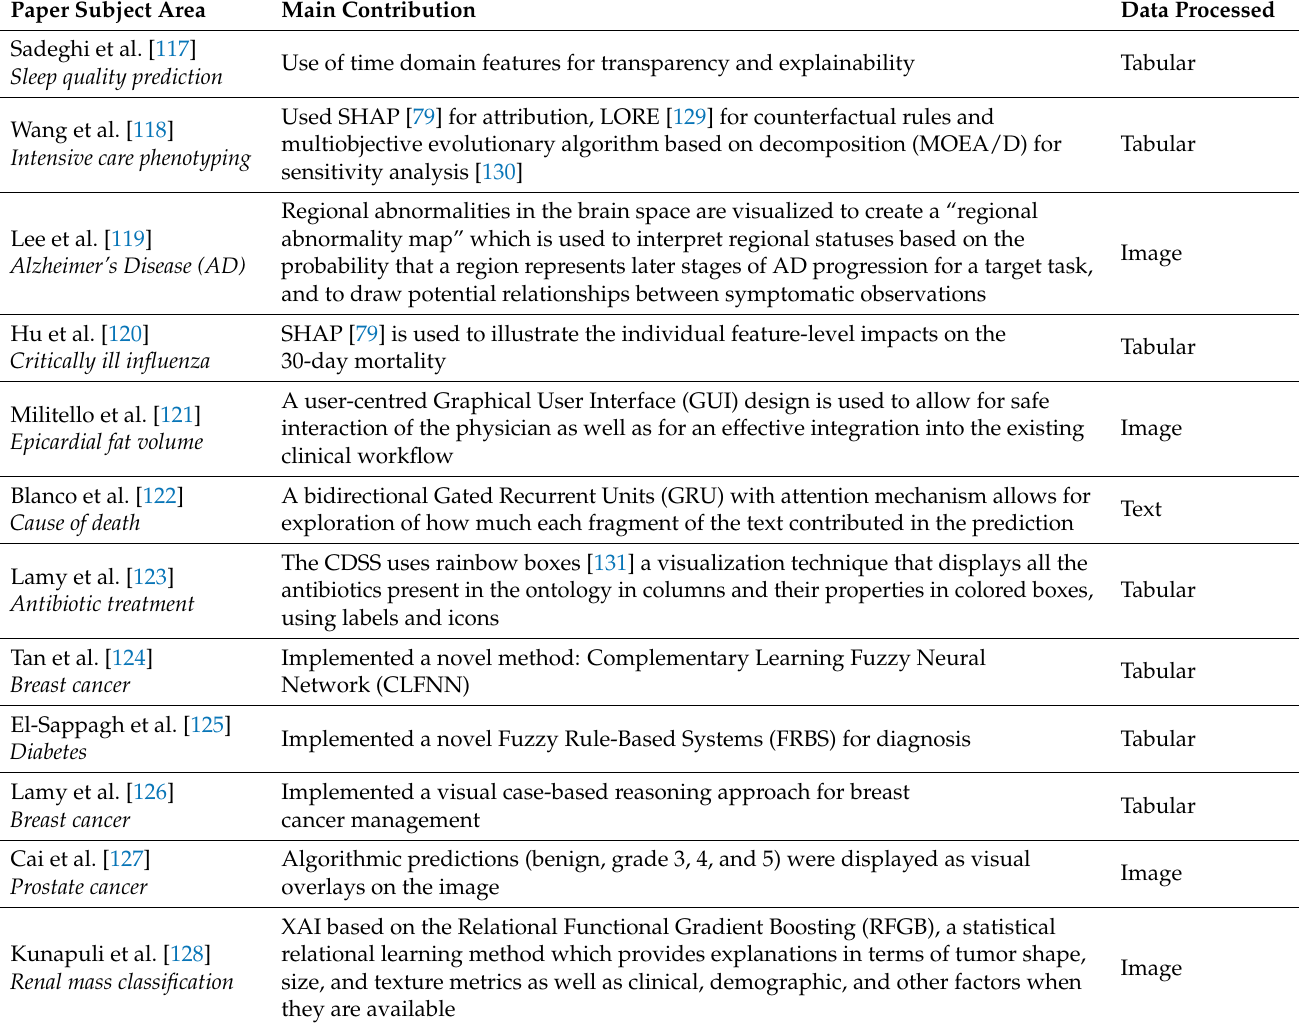
Table 1. Twelve publications reporting on CDSS that have implemented